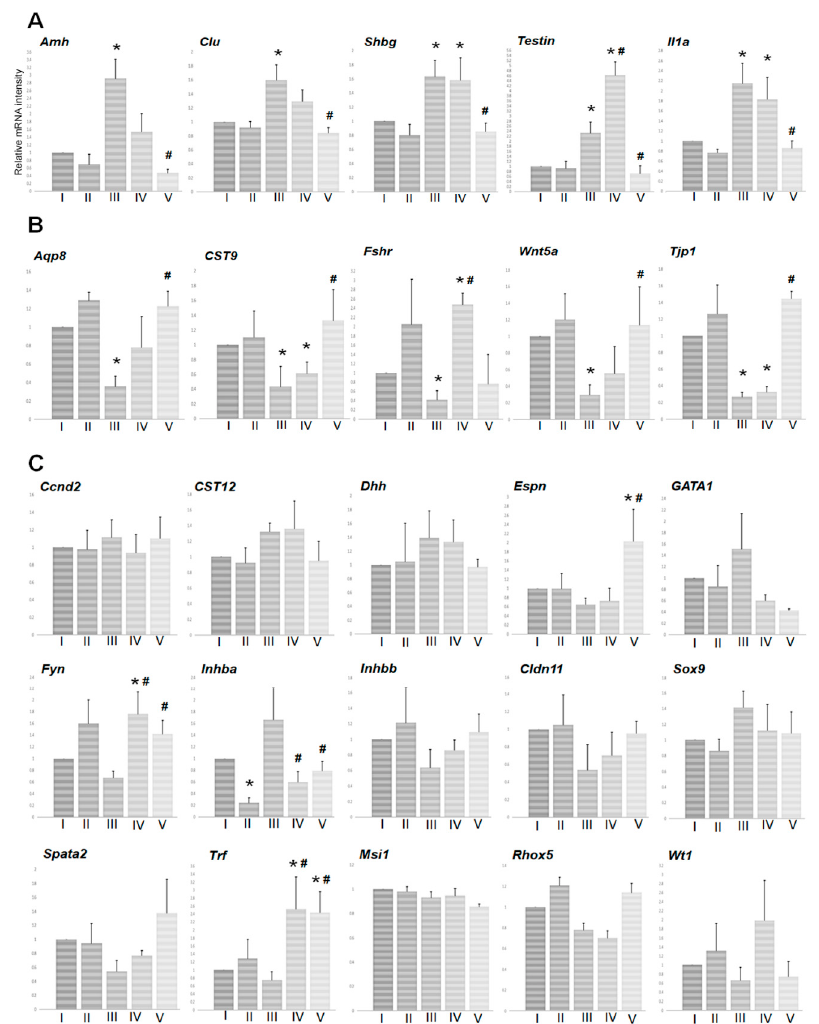
Figure 2. E ff ect of TL107 on the levels of 25 mRNA transcripts encoding markers of Sertoli cell-specific products in each group at day 120: expression was measured by real-time RT PCR, and the results are expressed relative to the internal control GAPDH . The results are expressed as the mean values ± standard deviation of five mice in each group, and the y-axis shows relative mRNA intensity. Transcripts showing a significant increase in levels after BSF treatment compared to control values are grouped in ( A ); transcripts showing a significant decrease in levels after BSF treatment compared to control values are grouped in ( B ). Transcripts that showed no change in levels after BSF treatment are grouped in ( C ). * p < 0.05 vs. group I; # p < 0.05 vs. group III.